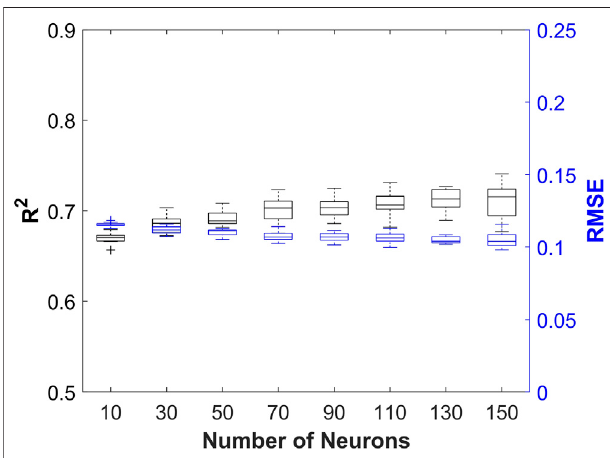
(2010) to optimize the weights and biases based on the mean square error. During training, the network was limited to only 1,000 epochs and six validation checks to avoid over fi tting the data. Data were separated 70% for training, 15% for testing, and 15% for validation at the beginning of each training process via random assignment. The 4,956 quality-controlled records ( Table 2 ) measured from 373 unique geographic locations in 16 wind directions were used to train the neural network. The model input consisted of 2 km of upwind terrain elevation data and 1 km of downwind terrain elevation data at each site in each wind direction. The input was chosen after comparing